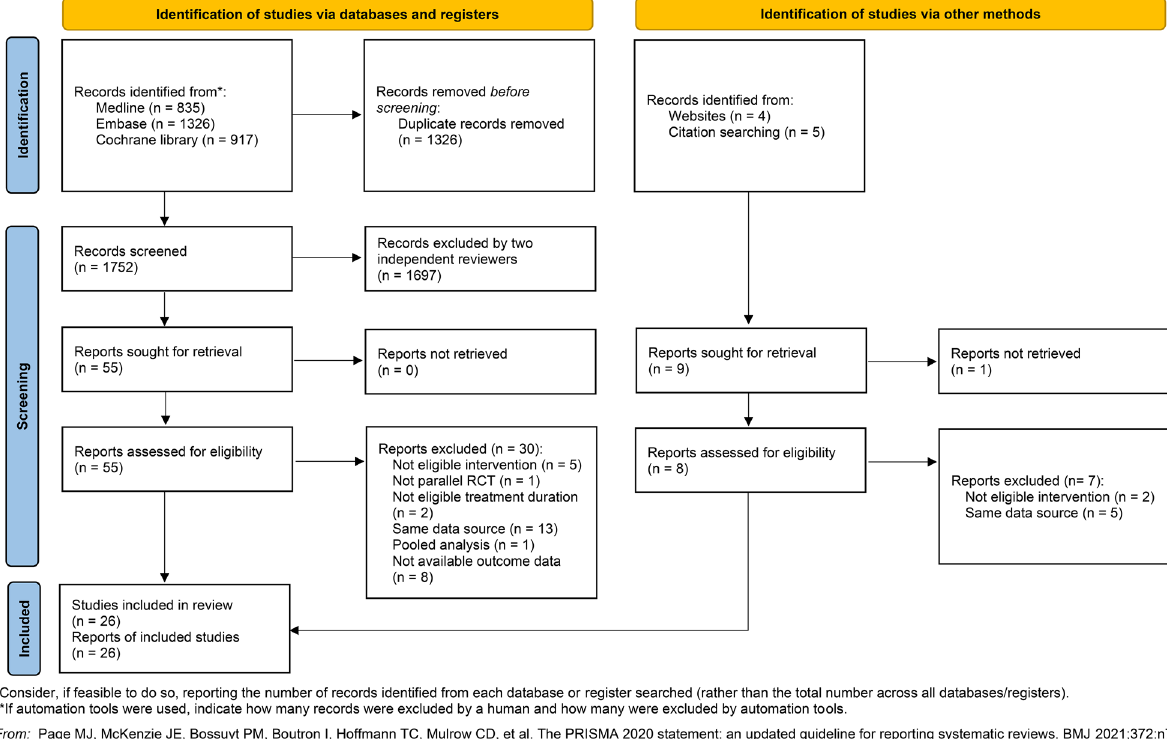
Figure 1. PRISMA flow chart for study inclusion in the systematic review and network